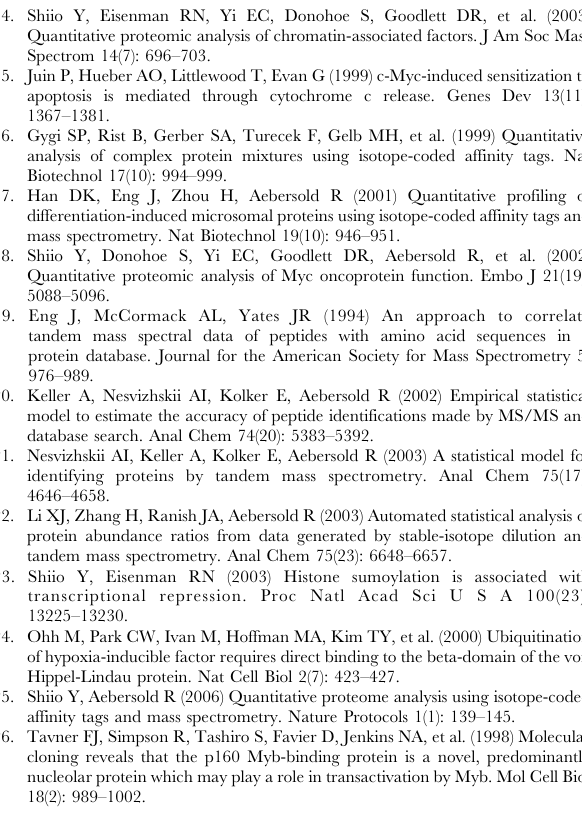
Table S1 List of proteins displaying more than 2-fold induction upon iron chelation.